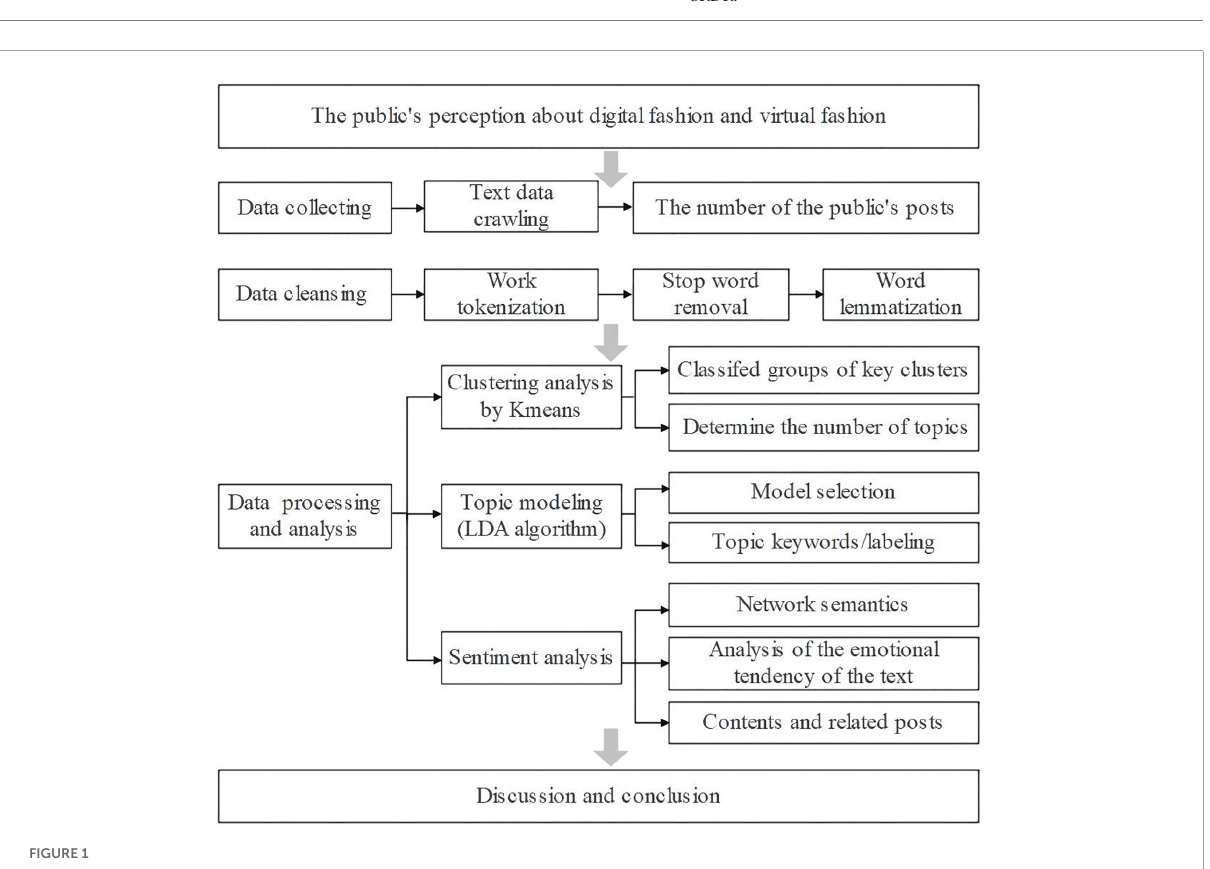
FIGURE1 Research